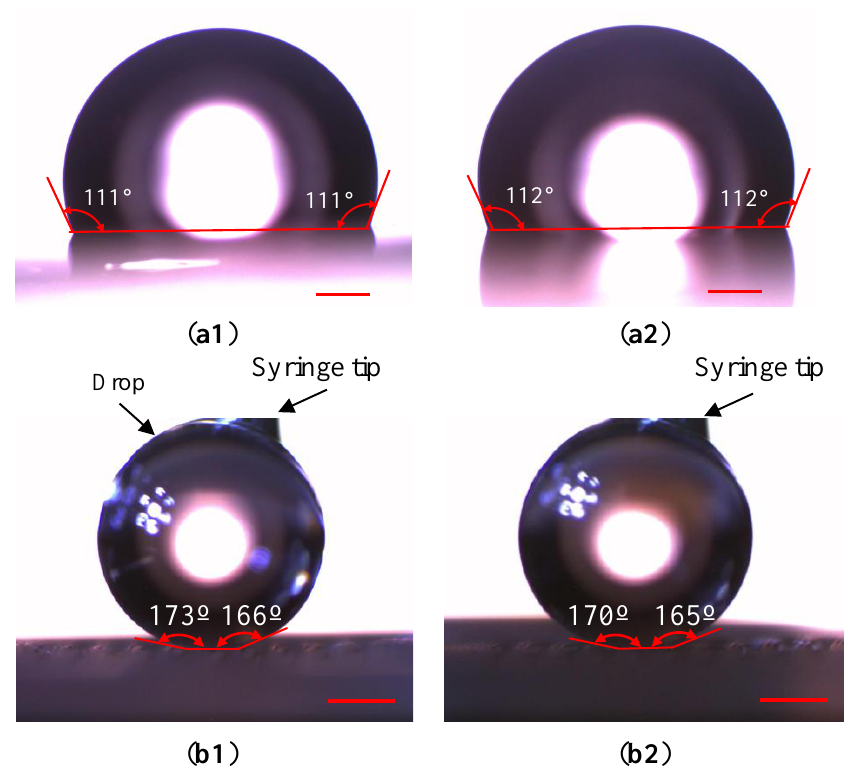
Figure 5. Contact angles on as-received PS sheets. ( a ) Before; and ( b ) After recovery; as well as those on surfaces structured with Channels ( b1 ) I and ( b2 ) II. The scale bars represent 450